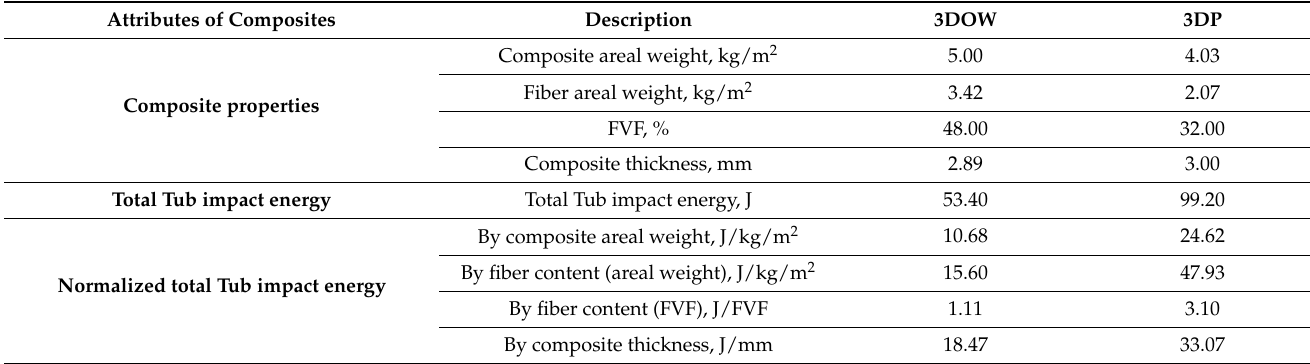
Table 3. Tub impact properties of 3D orthogonal woven (sample 28 from Midani et al. [29]) and 3DP (sample 0/90)